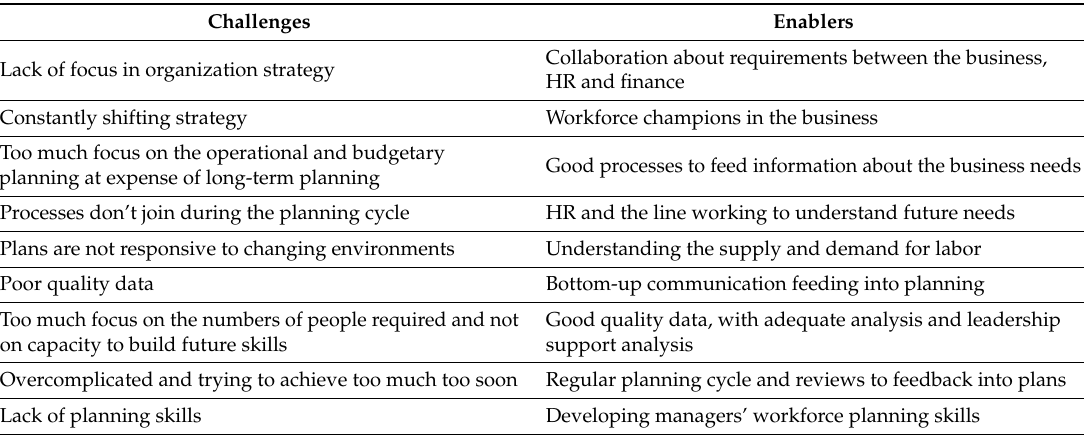
Table 5. Challenges and enablers of workforce planning